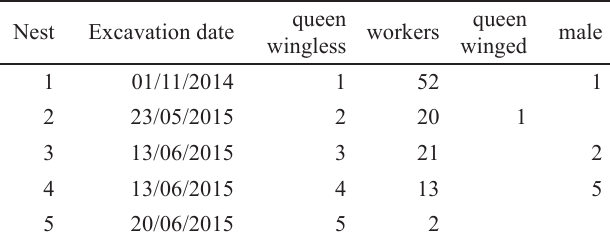
Table 1 . Nest excavations data for the new species Temnothorax ansei sp.n., discovered in 2014 in the south-east of